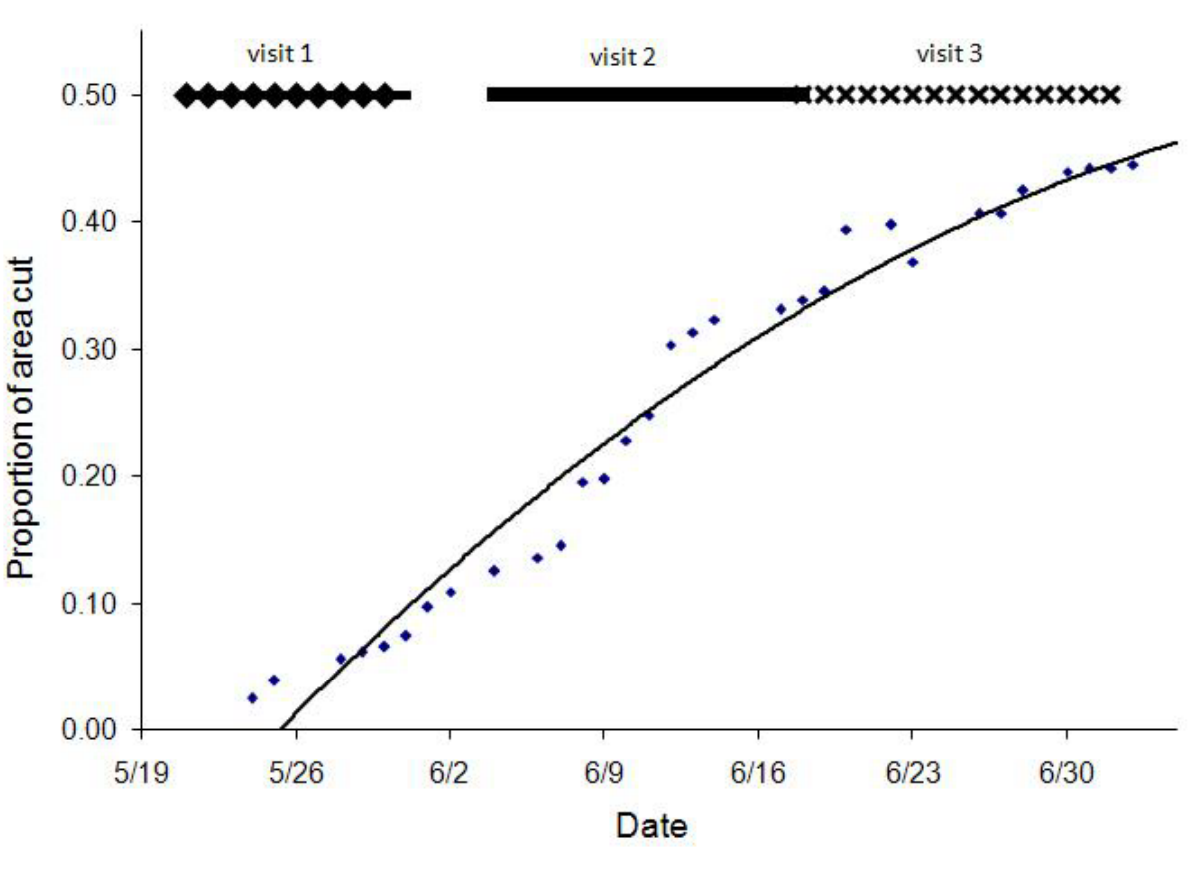
Fig. 1 . The proportion of the agricultural field area cut from May 21 to July 2, 2002 in the Champlain Valley of Vermont and New York. Proportions represent proportion of area (not proportion of fields, n = 142) that contained the bird and vegetation sampling stations. Data points represent mowed fields. The trend line suggests a slowing of cutting in late June and